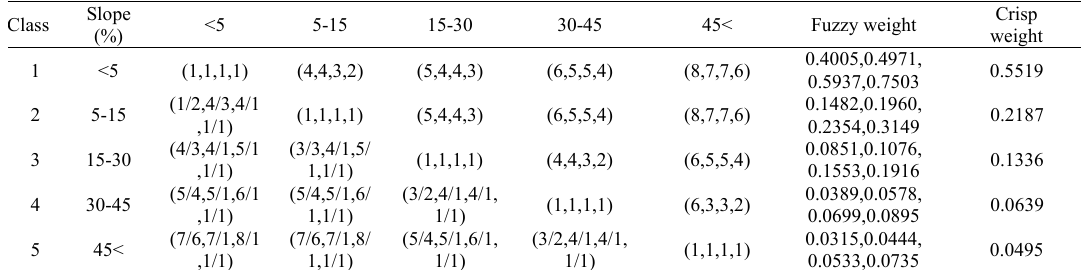
Table 4: Paired comparison matrix of fuzzy numbers, slope classes